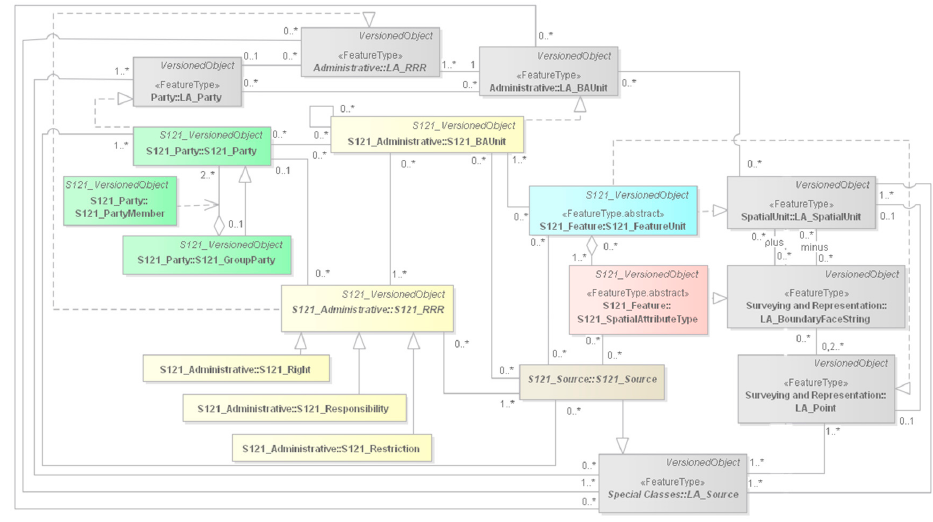
Figure 2. S-121 classes related to LADM.